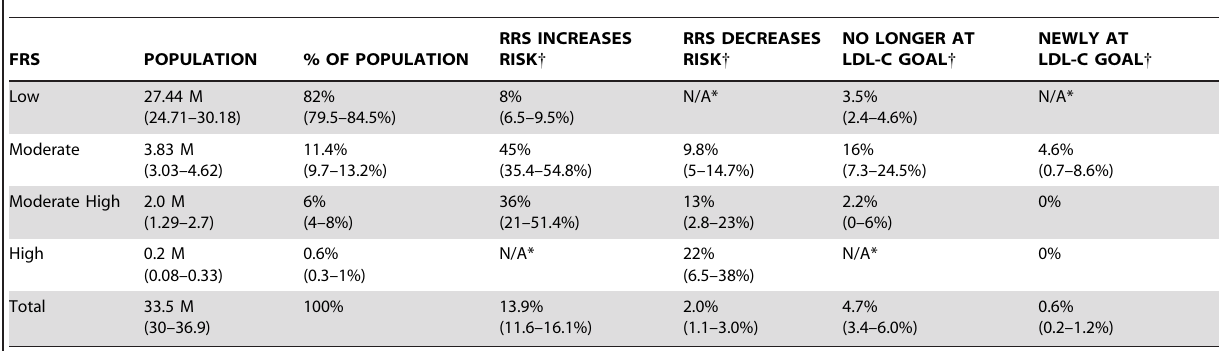
Table 4. Reynolds Risk Score Applied to Population of U.S. Women.